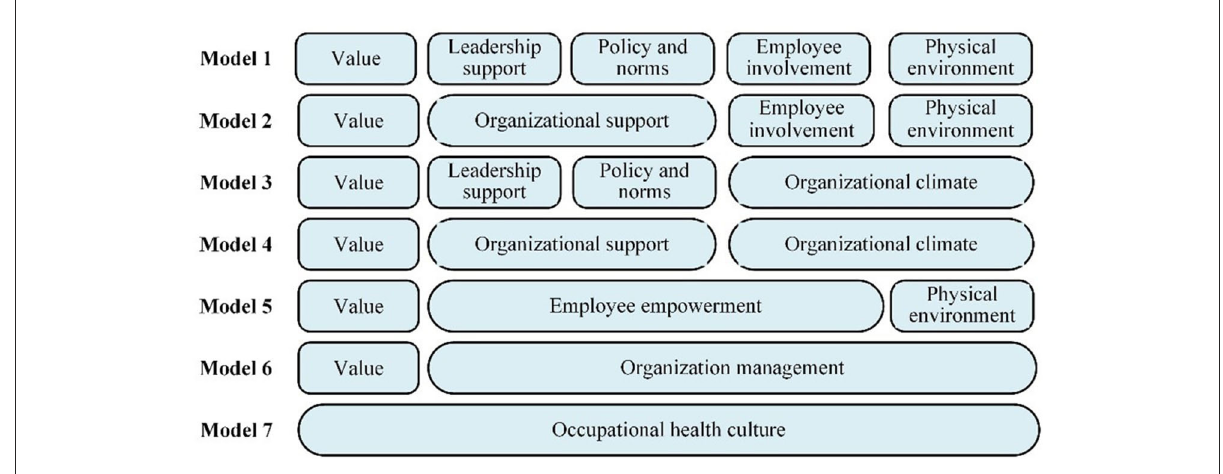
FIGURE3 Seven factor model occupational health culture.